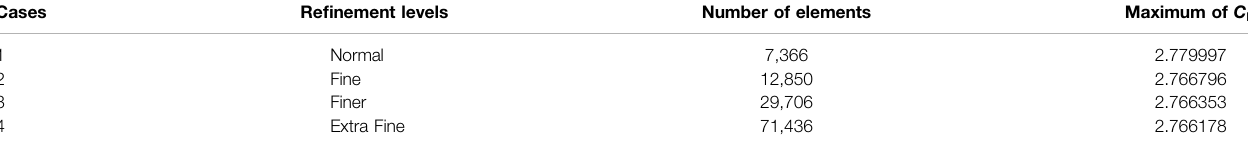
TABLE 2 | Test for grid independence using an attached splitter plate to the circular cylinder.